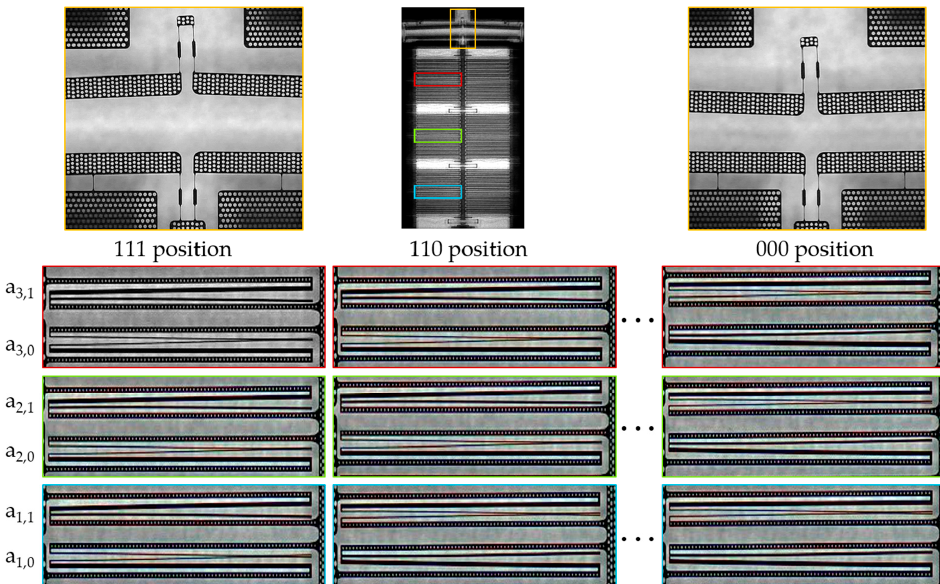
Figure 9. ( Top ) Middle: system 1, left: mechAMP+ in the 111 position, right: mechAMP+ in the 000 position. ( Bottom ) Left: actuators in the 111 position, middle: actuators in the 110 position, right: actuators in the 000 position. Due to the high aspect ratio, the length of the actuators is compressed by 50%.